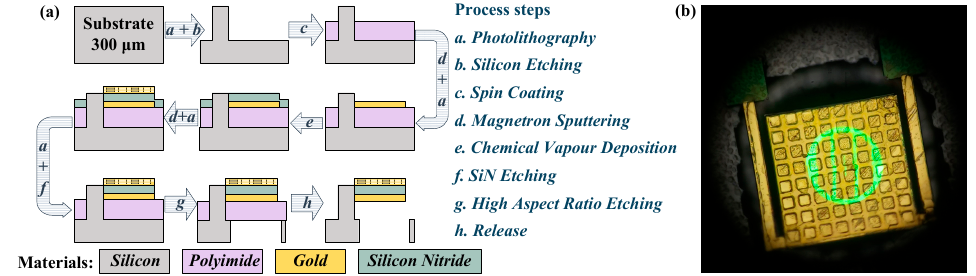
Figure 10. ( a ) The fabrication processes of optomechanical detector. ( b ) The top view of a single detector taken through a microscope.